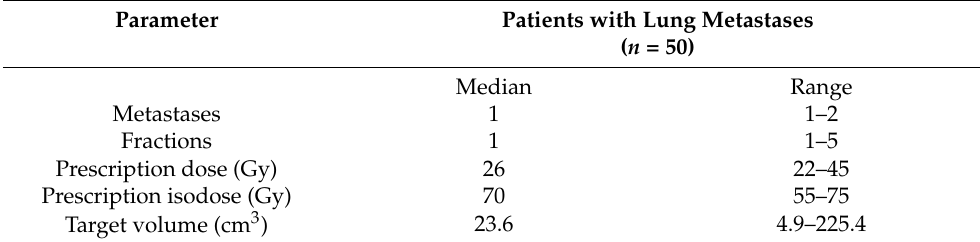
Table 2. Robotic radiosurgery treatment parameters.